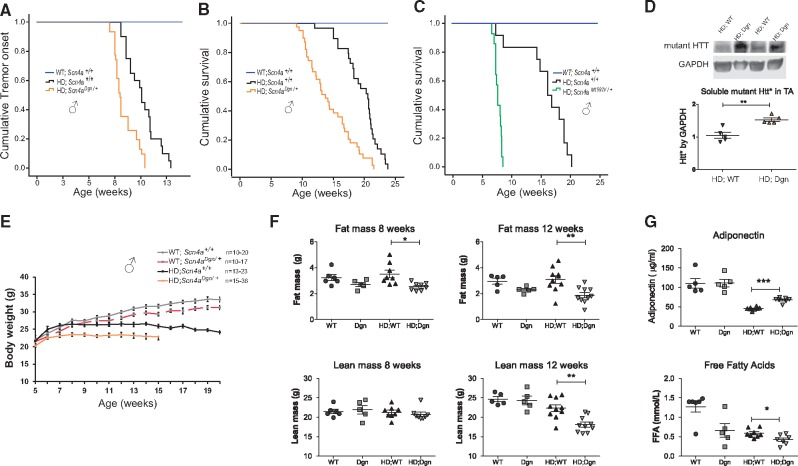

Scn4a mutations exacerbate HD leading to further metabolic alterations. (A) Cumulative tremor onset events from 7 weeks of age (HD; Scn4a+/+ (n = 20) average onset: 10.1 weeks; HD; Scn4aDgn/+ (n = 31) average onset: 8.4 weeks. P < 0.001). (B) Draggen mutation decrease survival on HD males (HD; Scn4a+/+ (n = 28) average survival: 19.4 weeks; HD; Scn4aDgn/+ (n = 39) average survival: 14.3 weeks. P < 0.001. (C) The M1592V Scn4a mutation decreases survival in HD male mice (HD; Scn4a+/+ (n = 12) average survival: 15.8 weeks; HD; Scn4aM1592V/+ (n = 14) average survival: 7.7 weeks. P < 0.001). (D) Representative immunoblot and analysis of levels of soluble mutant huntingtin from TA muscle corrected by GAPDH (n = 5, P = 0.0018). (E) Body weights from 5 weeks of age until disease end-point. At least 13 male mice per genotype and time-point, (P < 0.05 from 5 weeks onwards comparing HD; Scn4aDgn/+ to any other group). (F) Whole body fat and lean mass in male mice at 8 (n = 5 nonHD and n = 8 HD groups) and 12 weeks of age (n = 5 nonHD groups and n = 10 HD groups). (G) Free-fed circulating levels of adiponectin and free-fatty acids in plasma of male mice at 12 weeks of age (n = 5 nonHD and n = 8 HD groups). WT= WT; Scn4a+/+, Dgn= WT; Scn4aDgn/+, HD; WT= HD; Scn4a+/+ and HD; Dgn= HD; Scn4aDgn/+. *P < 0.05, **P < 0.01, ***P< 0.001.